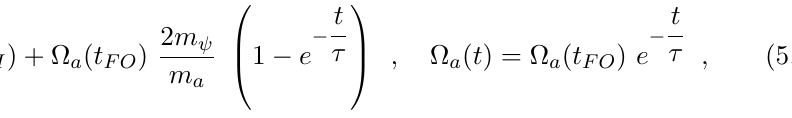
Figure 16. 2D projections of the allowed parameter space for m a ≤ 2 m ψ in the FIMP scenario B, after constraints given at the top of each frame. The colour maps indicate the individual relative relic density of the two DM components a ( Ω ( Ω Ω ) or their sum ( Ω ψ / Planck